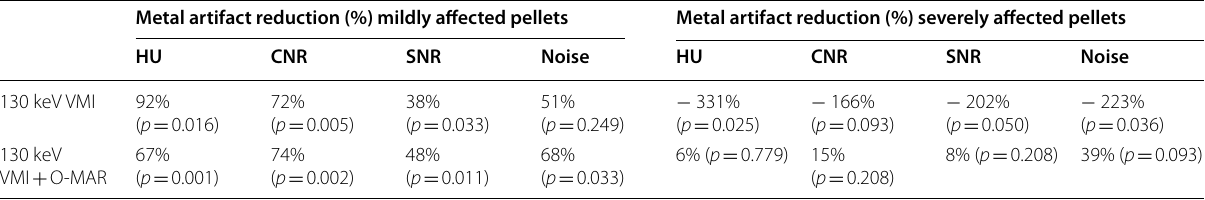
Table 4 Relative metal artifact reduction in CT values (HU), contrast-to-noise ratio, signal-to-noise ratio and noise in comparison to conventional (140kVp) with O-MAR